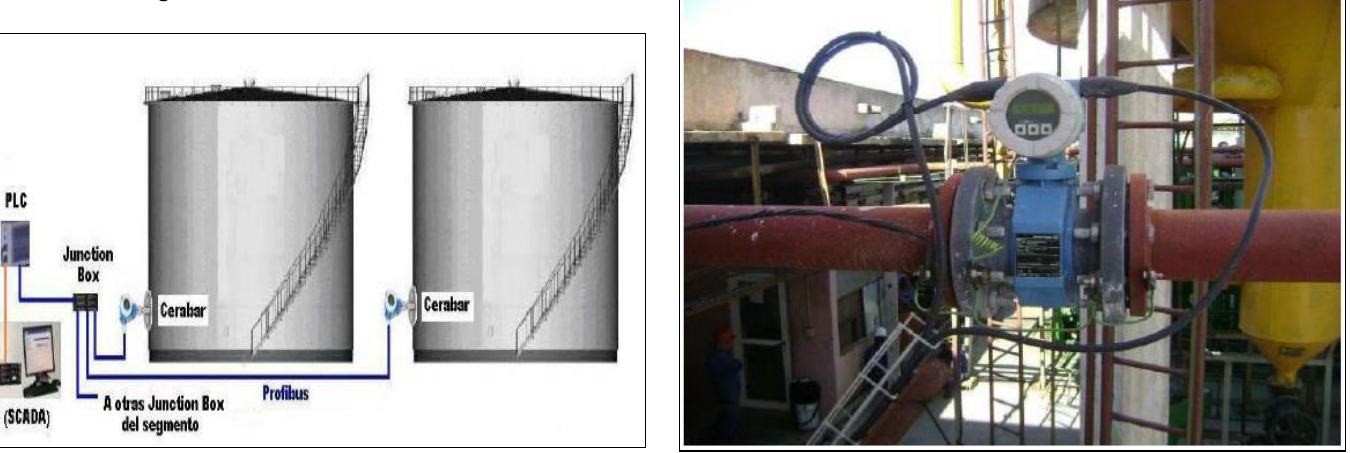
Figura 12: Flujómetro Promag 10P2F a la entrada de los tanques de agua